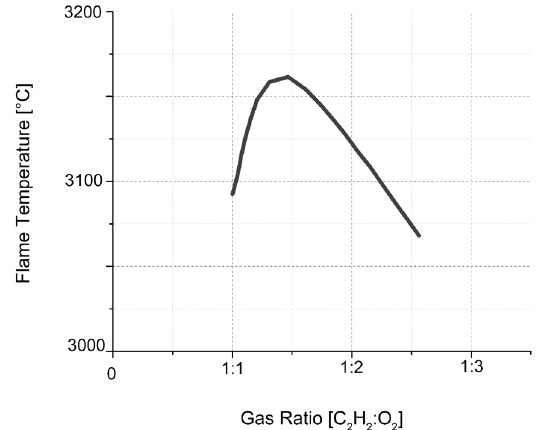
Figure 13. Temperature profile for oxy-acetylene combustion